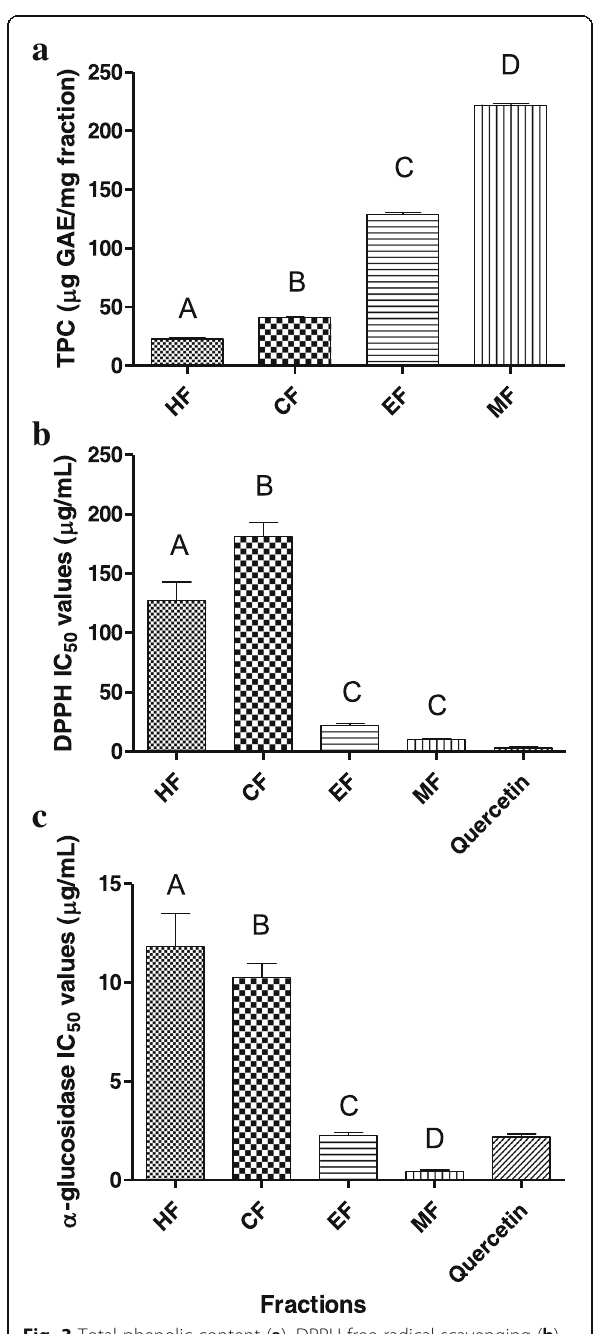
Fig. 3 Total phenolic content ( a ), DPPH free radical scavenging ( b ) and α -glucosidase inhibition ( c ) of different fractions of N. oleracea . The values are the means ± standard deviations. Means with different letters are significantly different ( P < 0.05). HF, hexane fraction; CF, chloroform fraction; EF, ethyl acetate fraction;